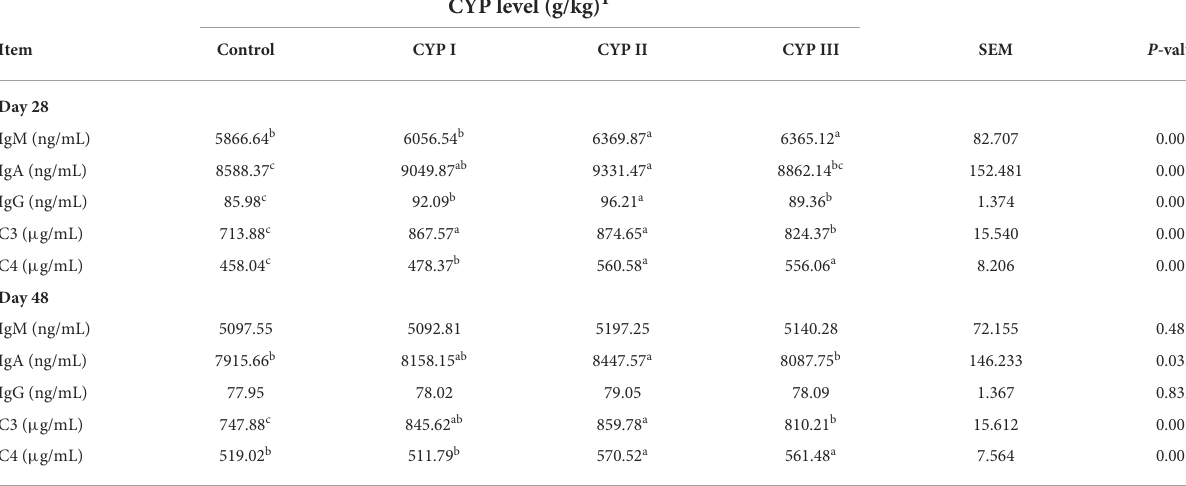
TABLE 3 Effects of CYP on the concentrations of serum immunoglobulins and complements C3 and C4 in